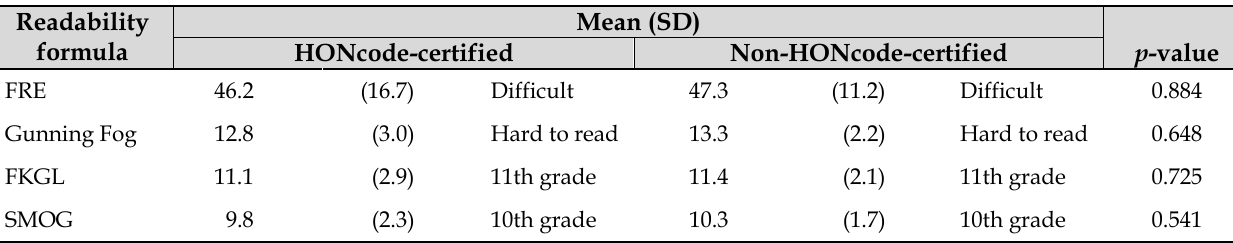
Table 4 Readability scores of websites depending on their Health On the Net Foundation code of conduct (HONcode) certification